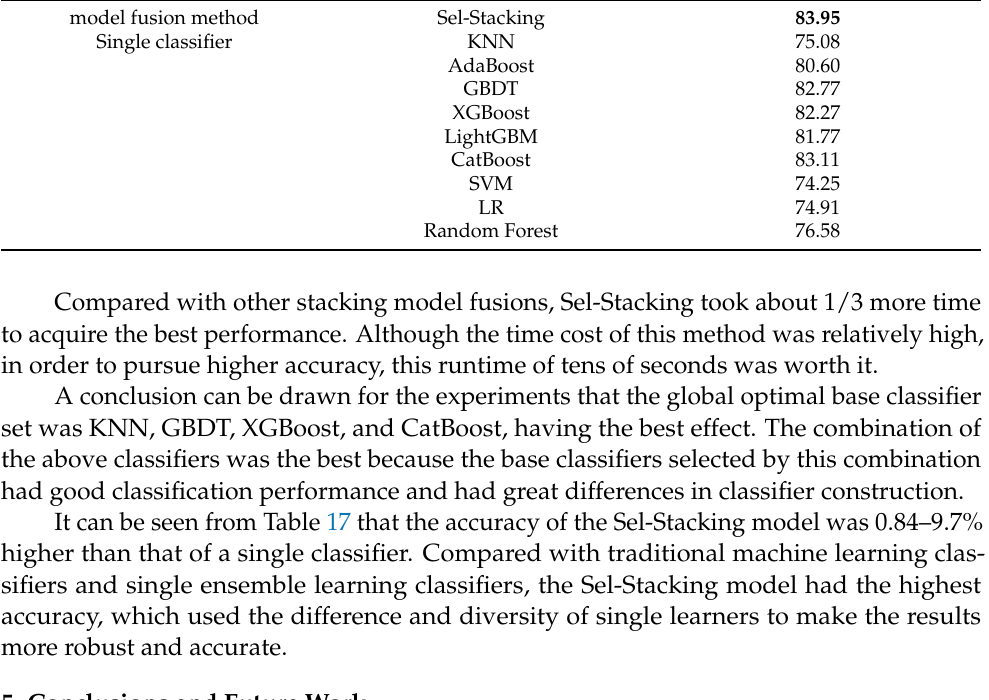
Table 17. The accuracy of the Sel-Stacking method and different single classifiers. Algorithm